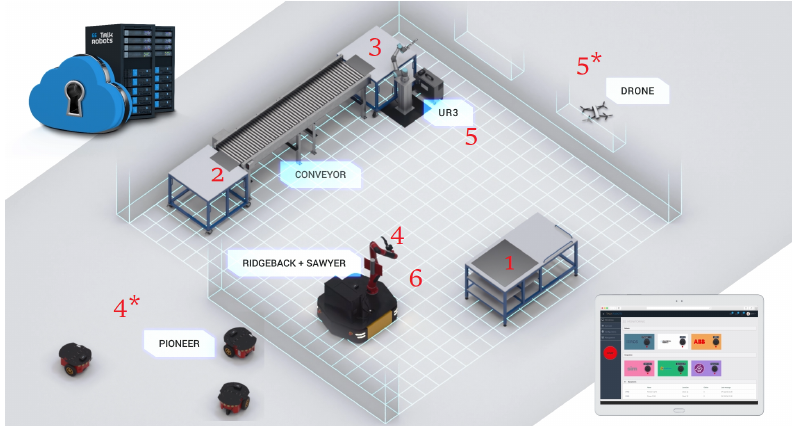
Figure 14. Prototype.